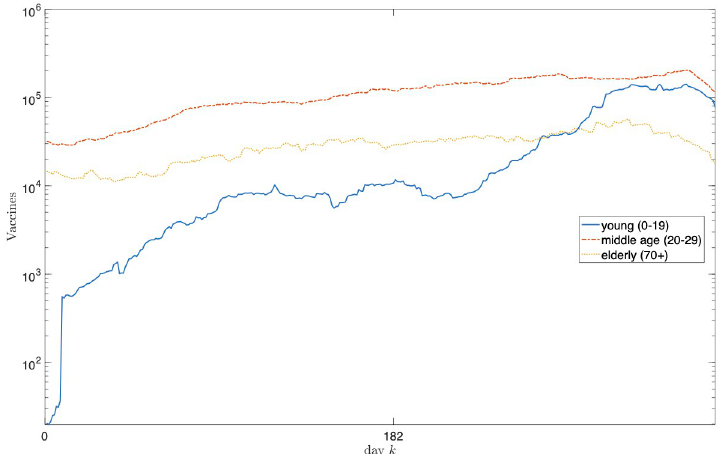
Fig 6. Intervention plan corresponding to the found solution in terms of the units of vaccines administered to the different age classes for each day. The plot aggregates the age classes into the young (0–19 years), middle-age (19–69 years) and elderly ( � 70 years) macro-classes. To improve readability, data has been smoothed using a 30-day moving average filter.